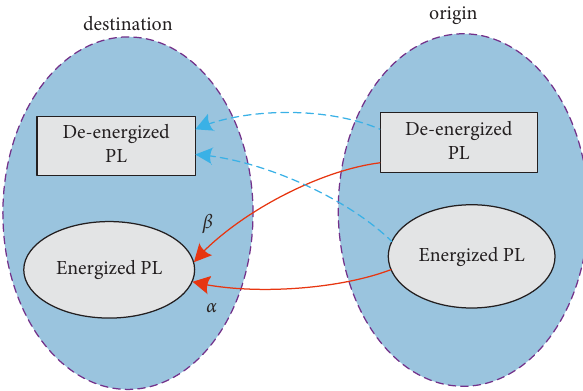
Figure 2: Graphical description for parameters α and β in 2nd trip.